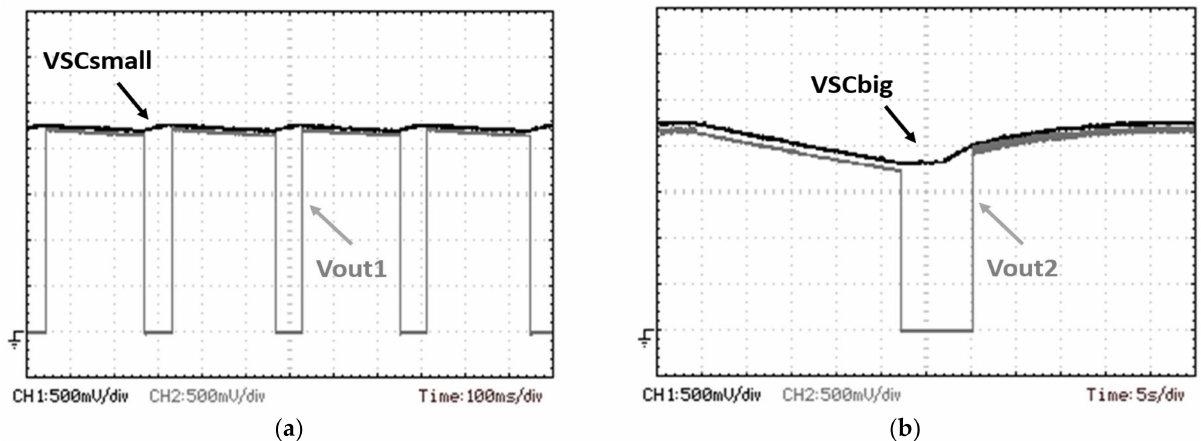
Figure 10. Oscilloscope view of ( a ) SCsmall voltage (CH1) and Vout1 (CH2) load output. ( b ) SCbig voltage (CH1) and Vout2 (CH2) load output. The output loads are disconnected in low-input energy conditions to preserve the operation of the system.